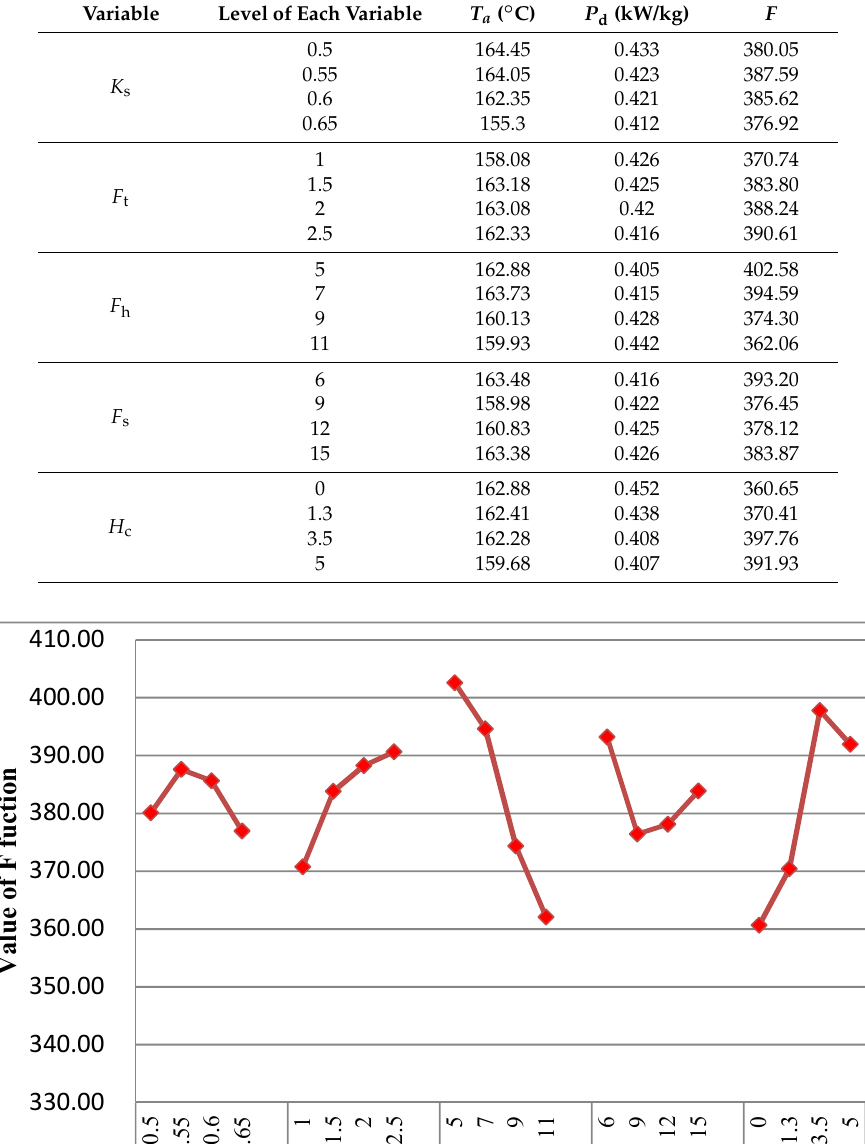
Table 12. Average values of the optimal objectives under each level of all optimal design variables.